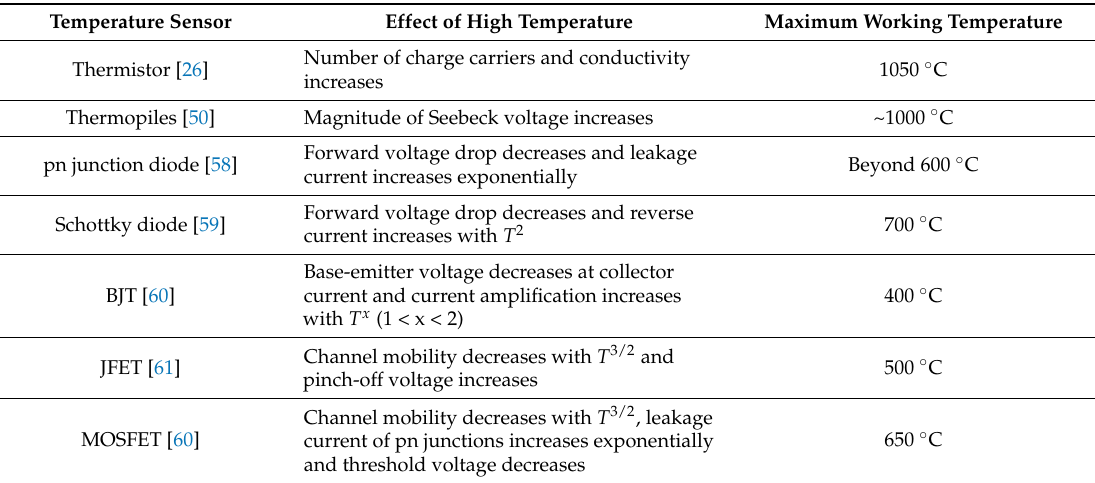
Table 1. Summary on the impact of high temperature on various thermal